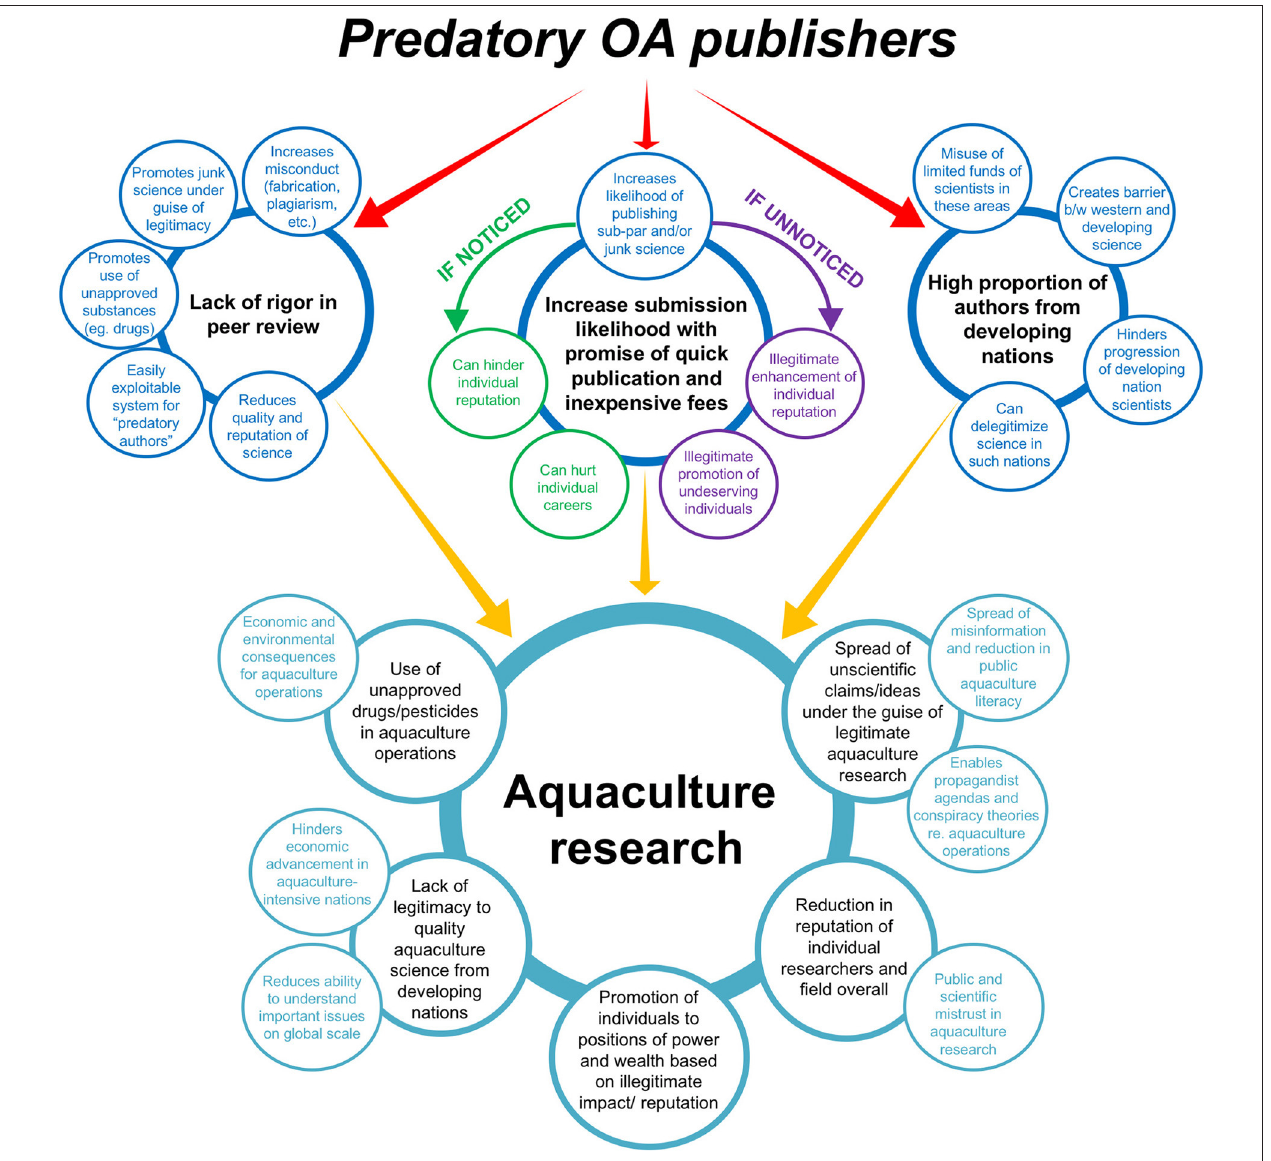
FIGURE 5 | Diagrammatic of three major ways in which predatory OA publishing threatens science (based on our results), and how such threats apply directly to aquaculture